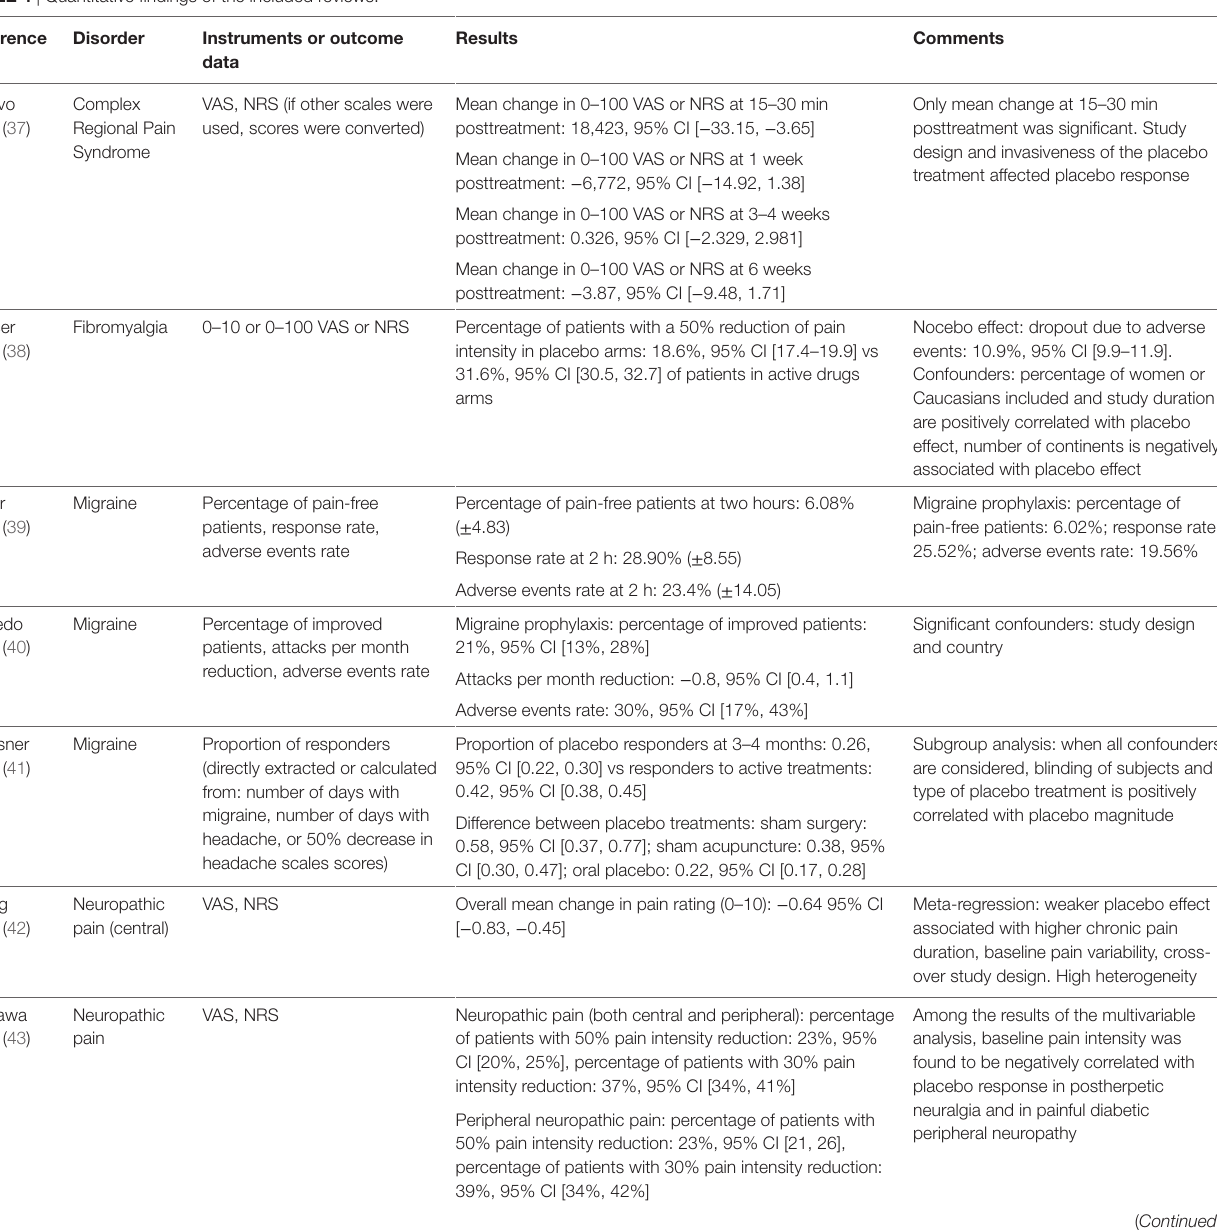
TaBle 4 | Quantitative findings of the included